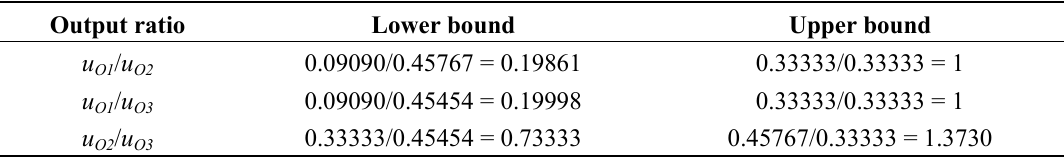
Table 12. Assurance ranges (AR) for